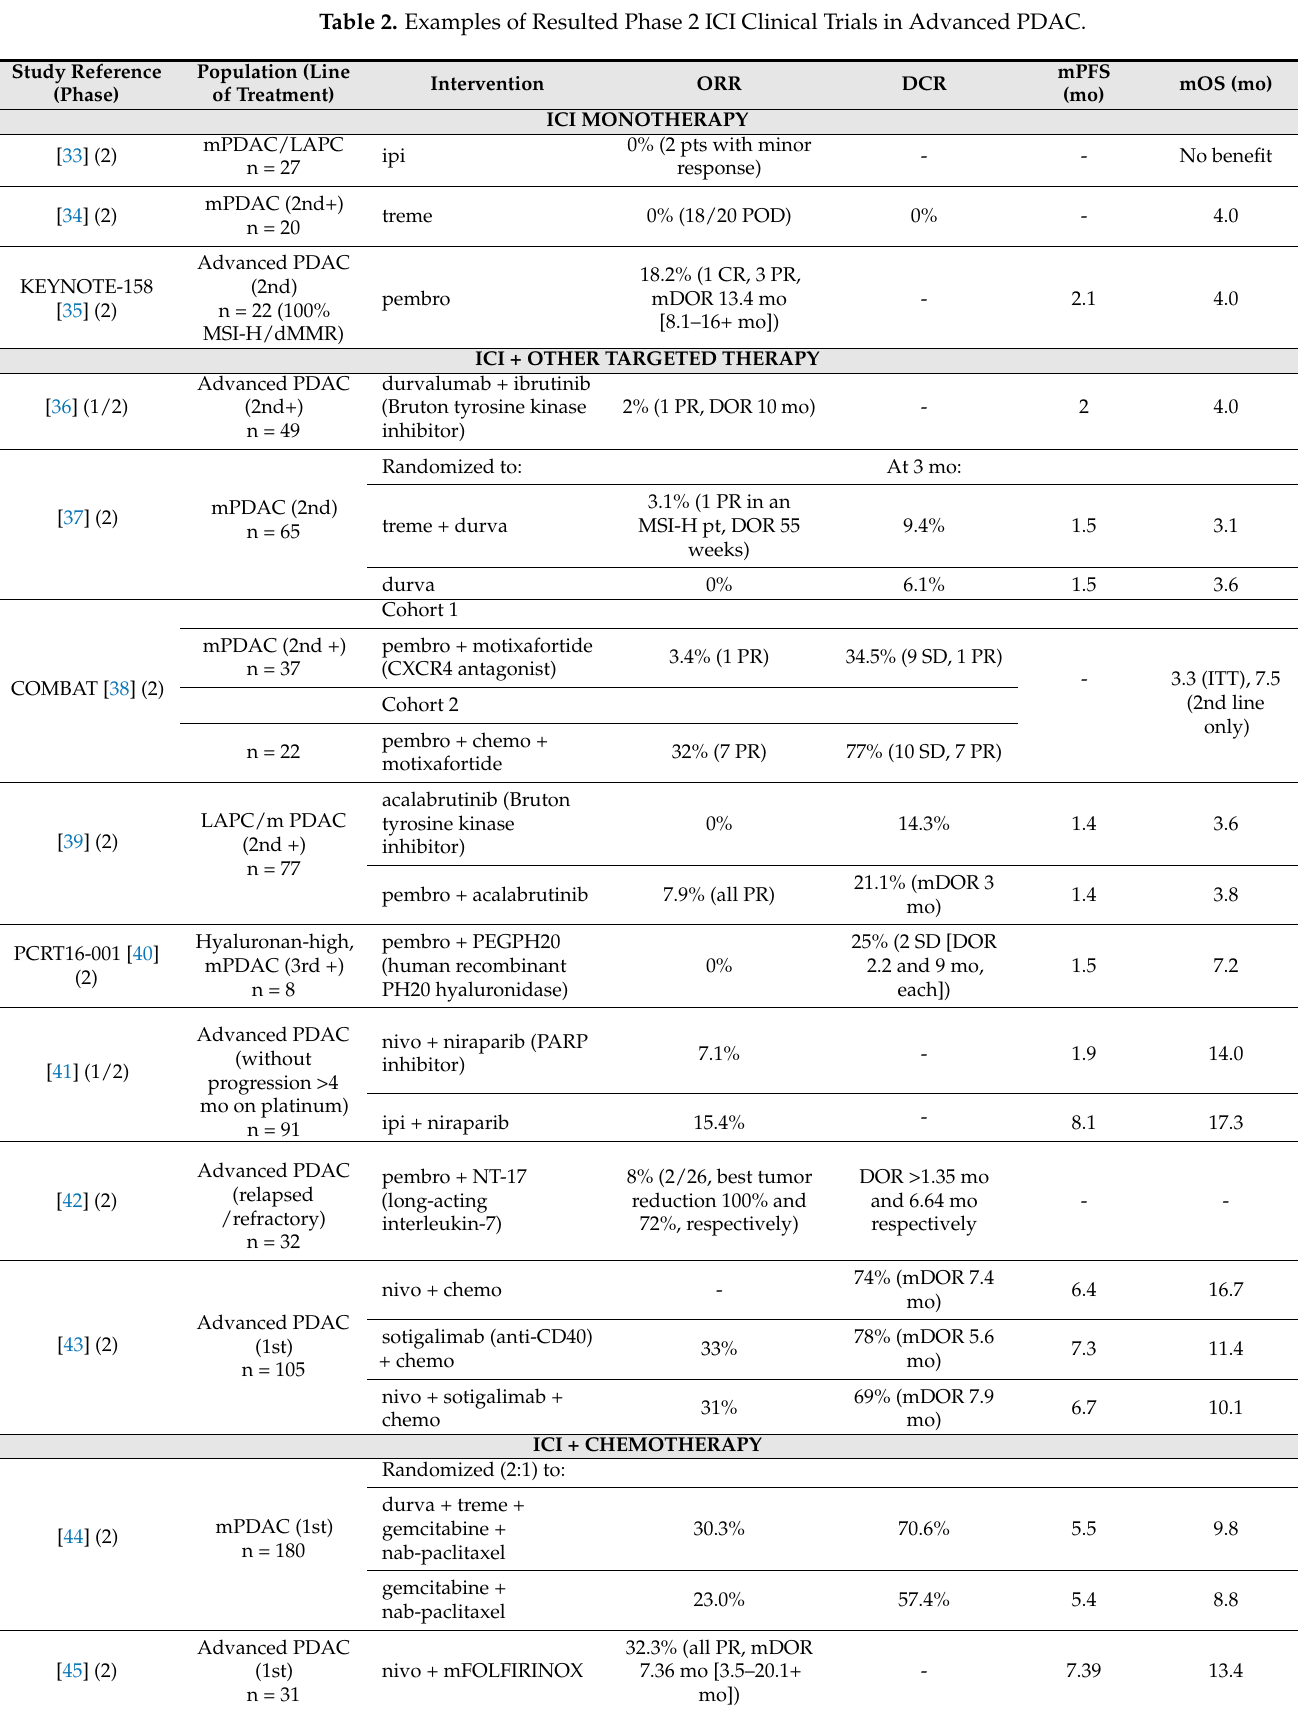
Table 2. Examples of Resulted Phase 2 ICI Clinical Trials in Advanced